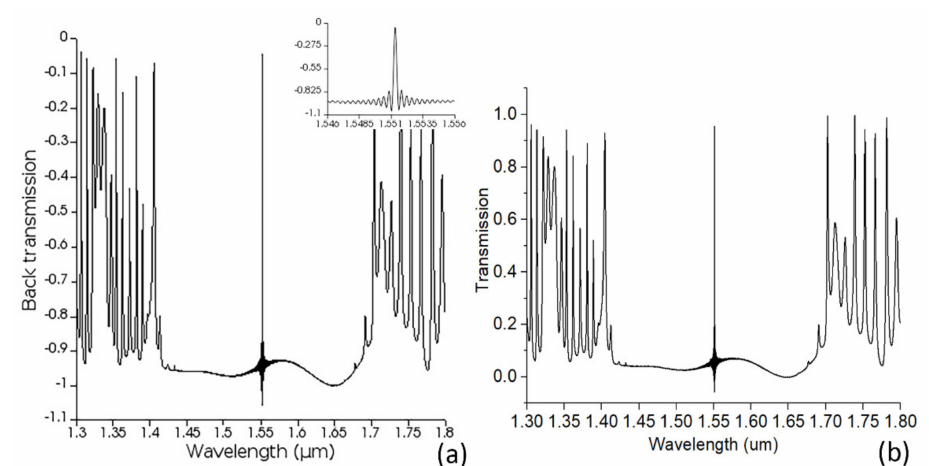
Figure 6. The simulated results of ( a ) the back transmission of 1D PhC with the ELM and ( b ) The mathematically manipulated result of ( a ) for positive